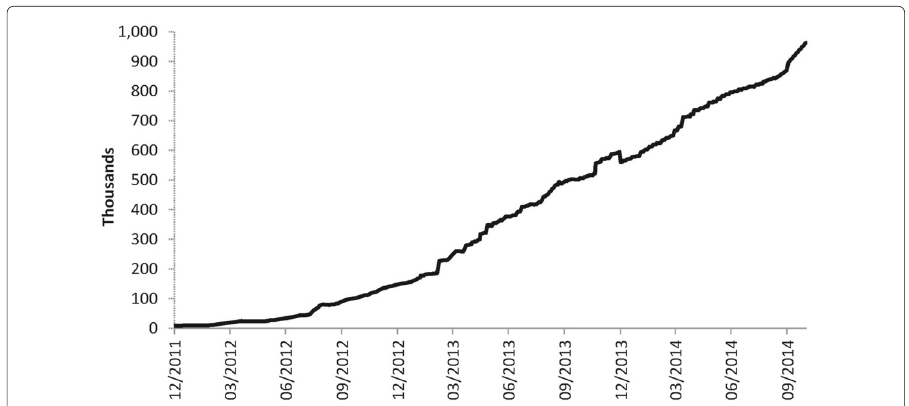
Fig. 1 Number of registered Syrian refugees in Turkey (thousands). Source: UN Refugee Agency, http://data.